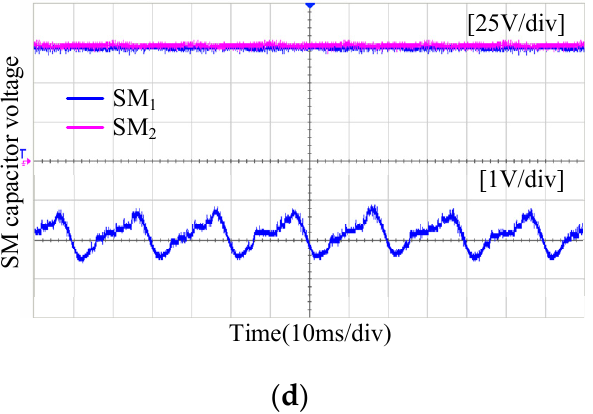
Figure 11. Experimental results under normal conditions ( a ) phase u voltage ( b ) line voltage u uv ( c ) current of phase u ( d ) some SM capacitor voltages of phase u and one zoomed-in curve.